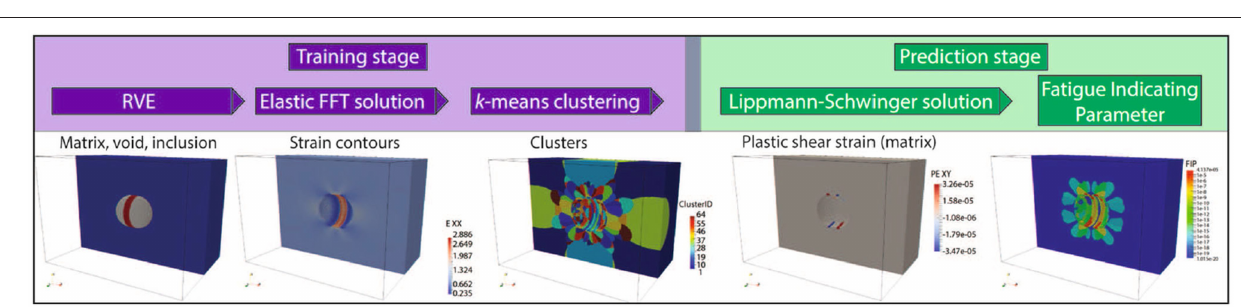
FIGURE 13 | Schematic overview of the implemented self-consistent clustering method based on an RVE of the material, sliced in the middle to show the matrix phase and hide inclusion and void phases (except in the first step). The workflow from left to right: training stage (blue) considers (1) gray inclusions and red voids, (2) matrix strain component ( ε xx ) of the linear elastic analysis; (3) strain clusters obtained through k -means clustering; and the prediction stage yields (4) plastic shear strain field from crystal plasticity and (5) the anticipated Fatigue Indicator Parameter. Reprinted from Kafka et al. (2018), Copyright (2018), with permission from Springer